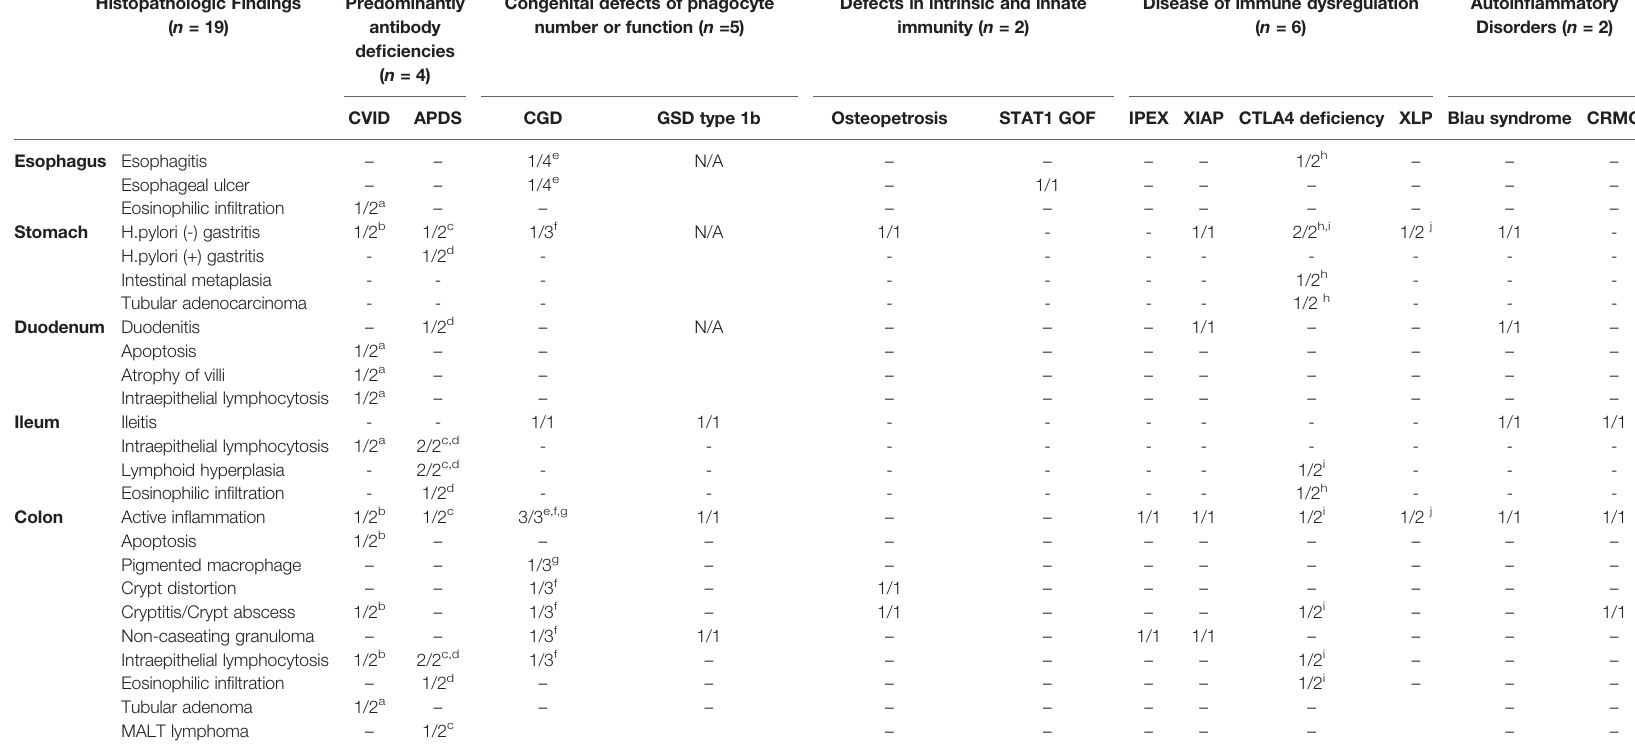
TABLE 5 | Histopathologic fi ndings of GI tract in patients with inborn errors of